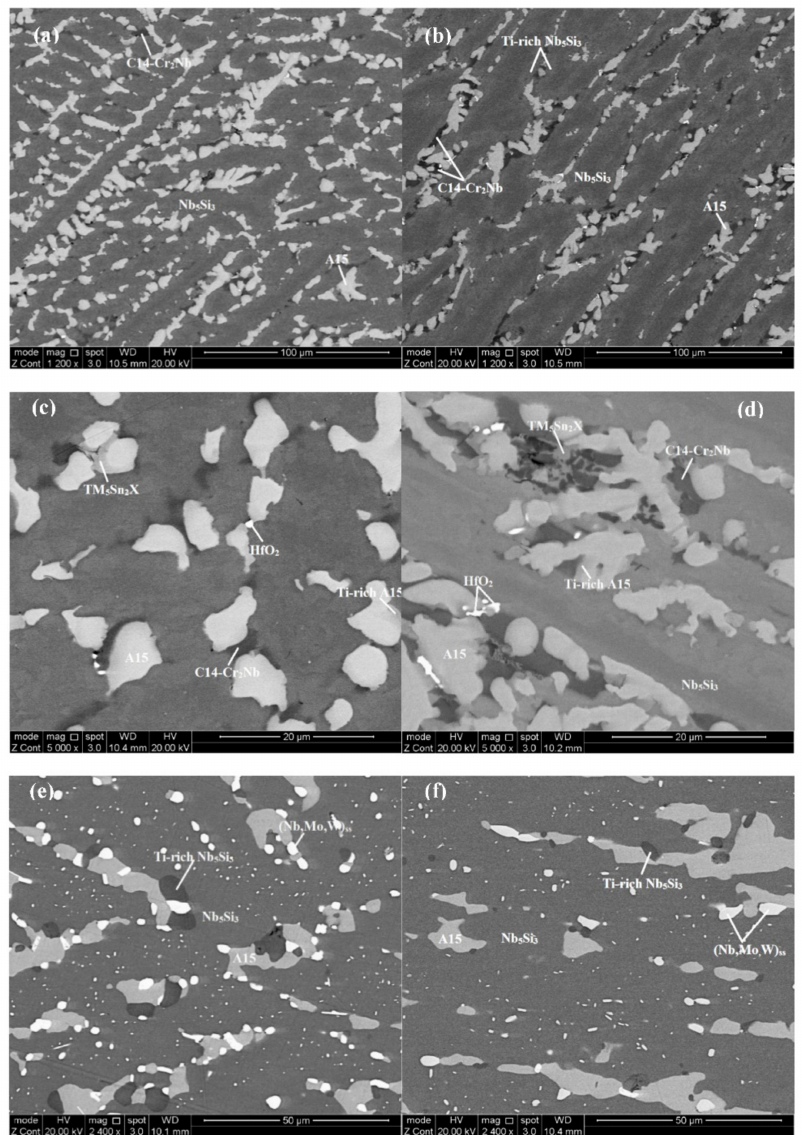
Figure 1. The as-cast ( a – d ) and heat-treated ( e , f ) microstructures of the alloys JZ4 ( a , c , e ) and JZ5 ( b , d , f